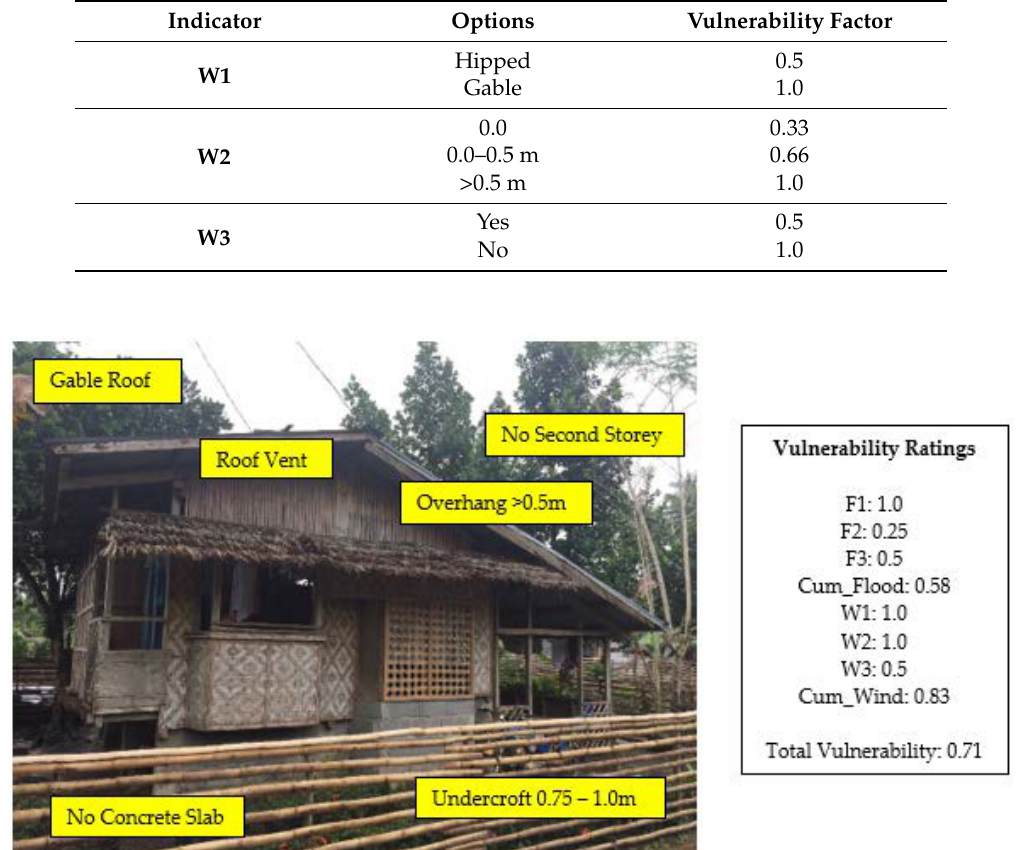
Figure 11. Example low vulnerability shelter from Calabnian.